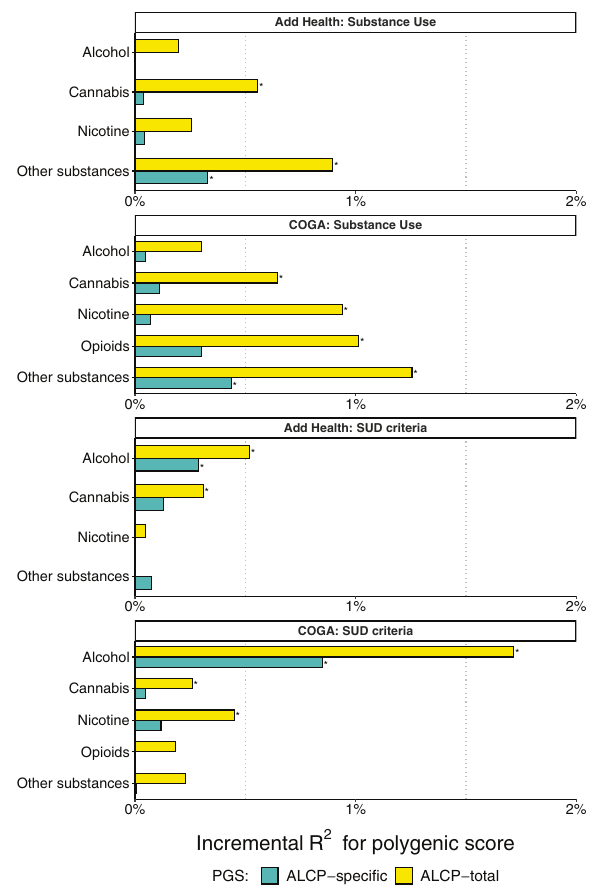
Fig. 3 Polygenic associations with substance use and substance use disorders. Bar charts illustrating the incremental proportion of variance (incremental R2, or Δ R2 above model with age, sex, PCs, and study-speci fi c covariates) explained by the polygenic score in Add Health ( N = 5107) and COGA ( N = 7594). Association between polygenic scores and lifetime SUD criterion counts for alcohol, cannabis, nicotine, other illicit substances, and opioids (COGA only). Asterisks (*) represent polygenic scores that are signi fi cant after correcting for an FDR of 5%.